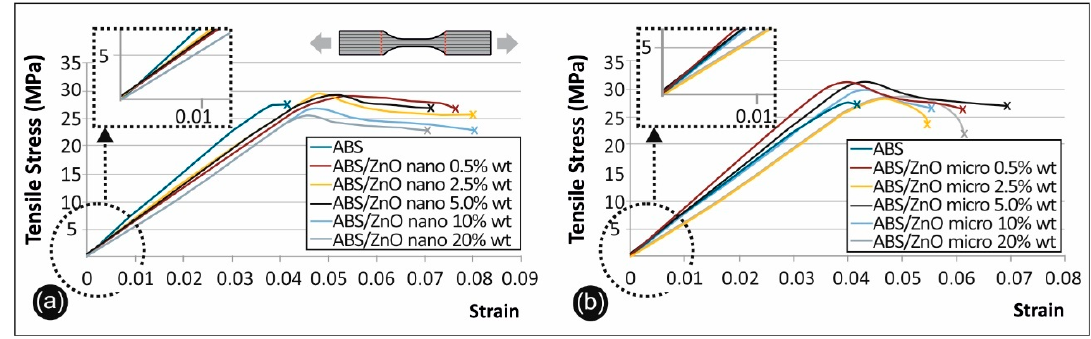
Figure 7. ( a ) Tensile stress vs. strain graphs for ABS / ZnO nano and ( b ) ABS / ZnO micro.